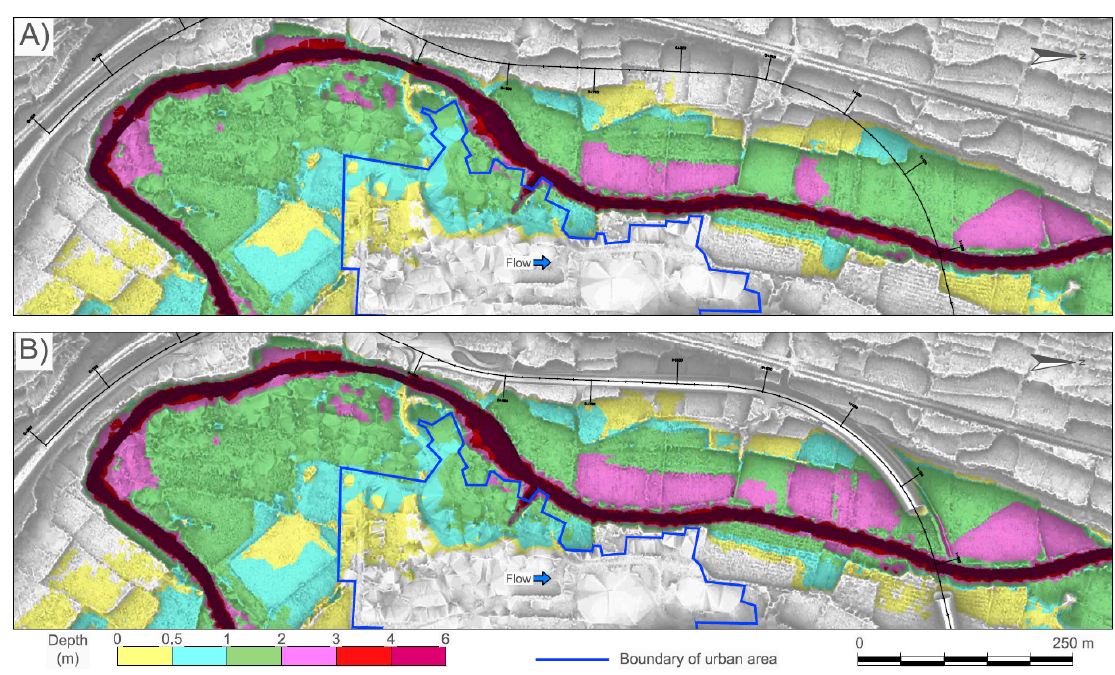
Figure 2. Water depth coverage: ( A ) initial state without bridge and ( B ) final state with the bridge from option 3. In this Figure and the following one, for the sake of detail, only the most representative part of the calculation domain is represented.